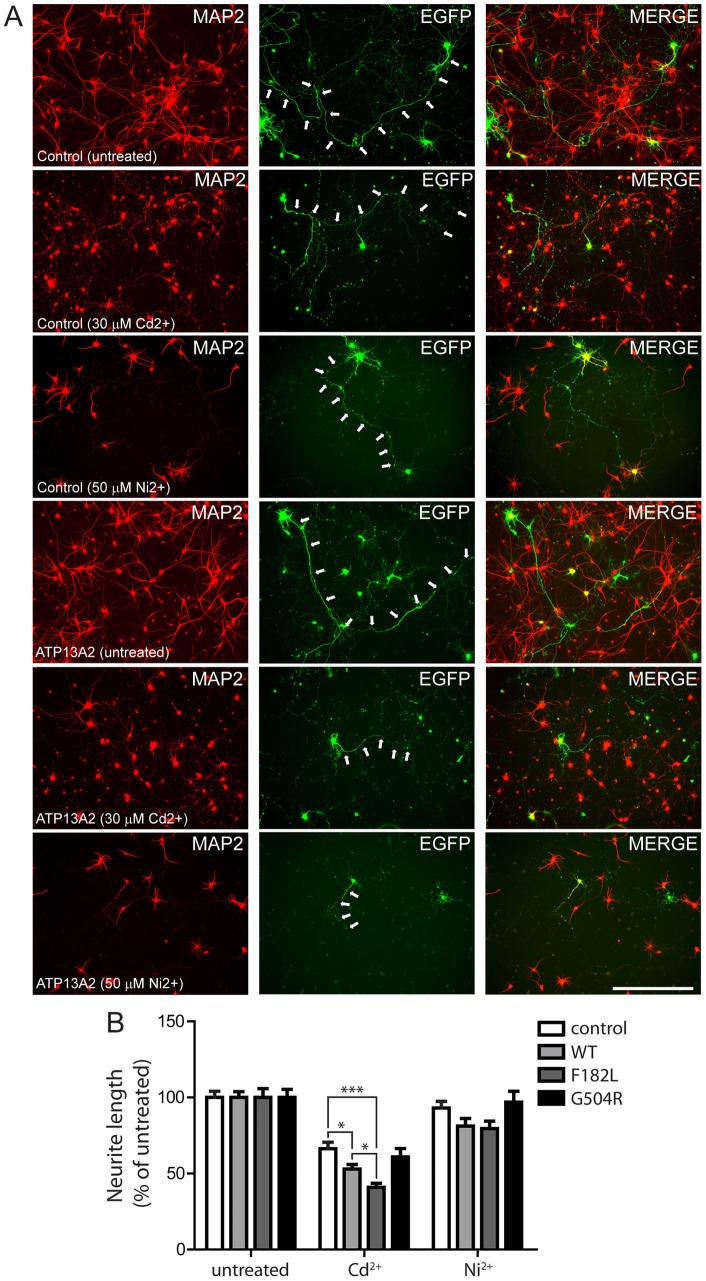
Overexpression of ATP13A2 sensitizes cortical neurons to heavy metal-induced neurite shortening. A
, Rat primary cortical neurons were co-transfected at DIV 3 with V5-tagged human ATP13A2 variants (or control empty vector) and EGFP plasmids at a DNA molar ratio of 10∶1. Cultures were treated without or with cadmium (Cd2+, 30 µM) or nickel (Ni2+, 50 µM) for 24 h and then fixed at DIV 6. Representative fluorescent micrographs reveal the co-labeling of MAP2+ cortical neurons with EGFP for each condition. Axonal processes are indicated with arrows. Scale bar: 400 µm. B, Analysis of the length of EGFP+/MAP2+ neurites reveals that the overexpression of WT or F182L ATP13A2 sensitizes cortical neurons to neurite shortening induced by treatment with 30 µM Cd2+ or 50µM Ni2+ for 24 h, compared to neurons expressing G504R ATP13A2 or EGFP alone (control). Data represent neurite length (mean±SEM; control, n = 73–156 neurons; cadmium, n = 39–119 neurons; nickel, n = 32–72 neurons; from three independent cultures) expressed as a % of untreated neurons (control or ATP13A2 overexpression). *P<0.05 or ***P<0.001 as indicated by one-way ANOVA with Newman-Keuls post-hoc analysis.